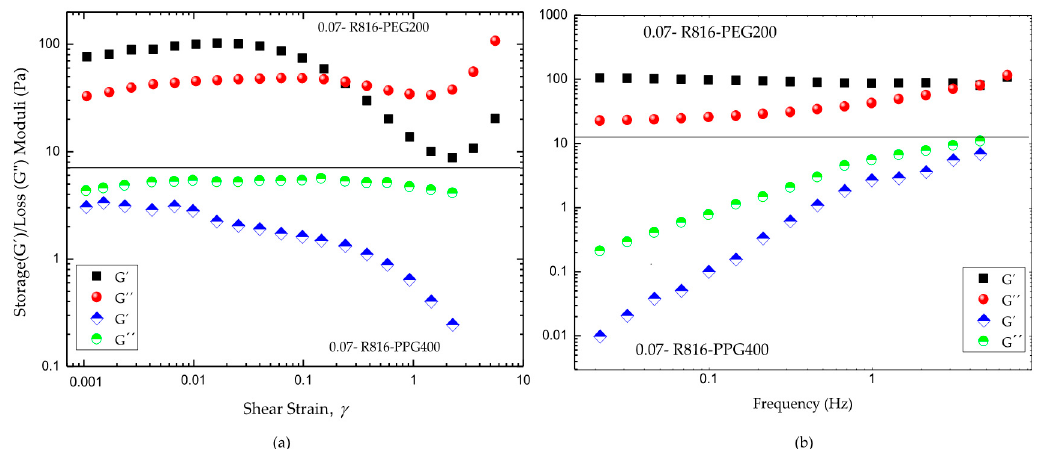
Figure 8. ( a ) Comparative strain sweep tests of fumed silica in PPG400 and PEG200 suspensions ( φ = 0.07 ) . ( b ) Comparative frequency sweep tests in the linear viscoelastic regions of fumed silica in PPG400 and PEG200 suspensions ( φ = 0.07 ) . All the uncertainties in the experimental points are under 0.1% .